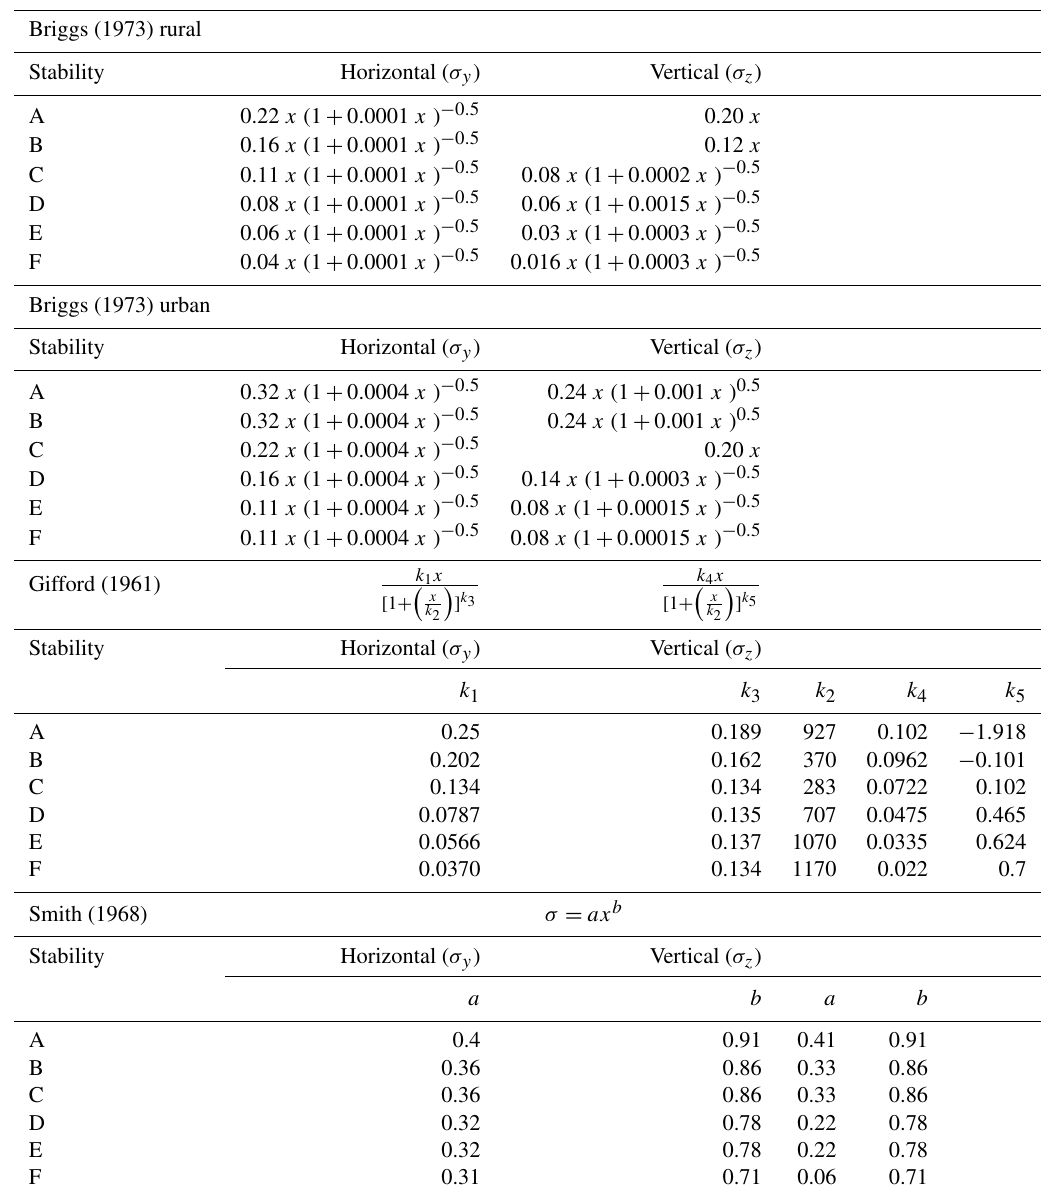
Table A1. Diffusion equations (m) as presented in Zannetti